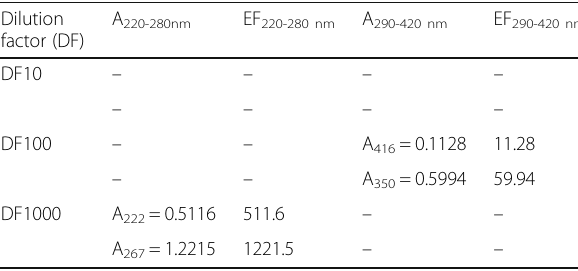
Table 1 Specific absorption values for the extract and